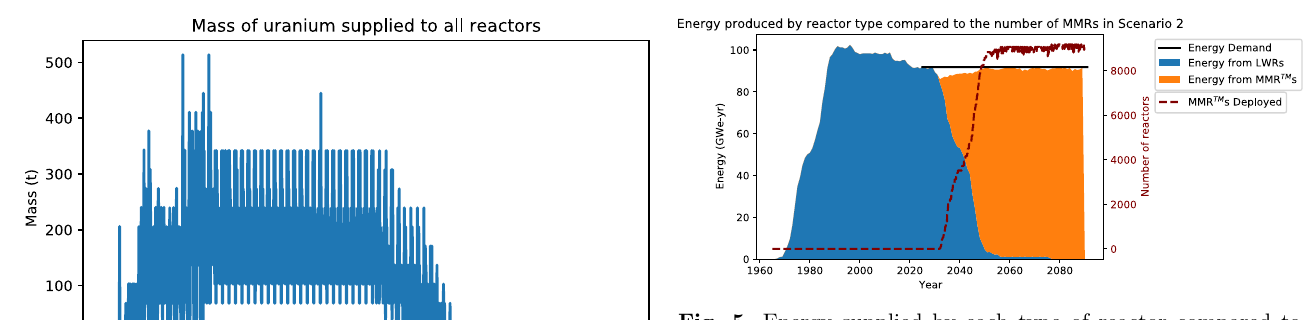
Fig. 5. Energy supplied by each type of reactor compared to the number of MMRs deployed in Scenario